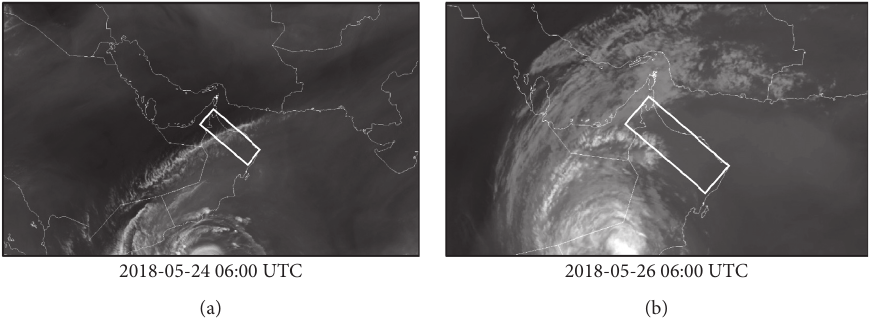
Figure 17: WV7.3 μ m images for (a) 24 May 2018 0600UTC and (b) 26 May 2018 into different colors in the DCMP: “green” for small ice thin color in Figure 22. The impact of the TC started on 24 May cirrus cloud and “dark brown” for large ice thin cirrus with the advection of thin cirrus clouds with small ice (Figure 21(c)) and then waned on day 26 with the dissipation particle (green in DCMP RGB) (Figure 21(a)). As the TC of the TC. intensified on the 25th of May, the cirrus clouds appeared